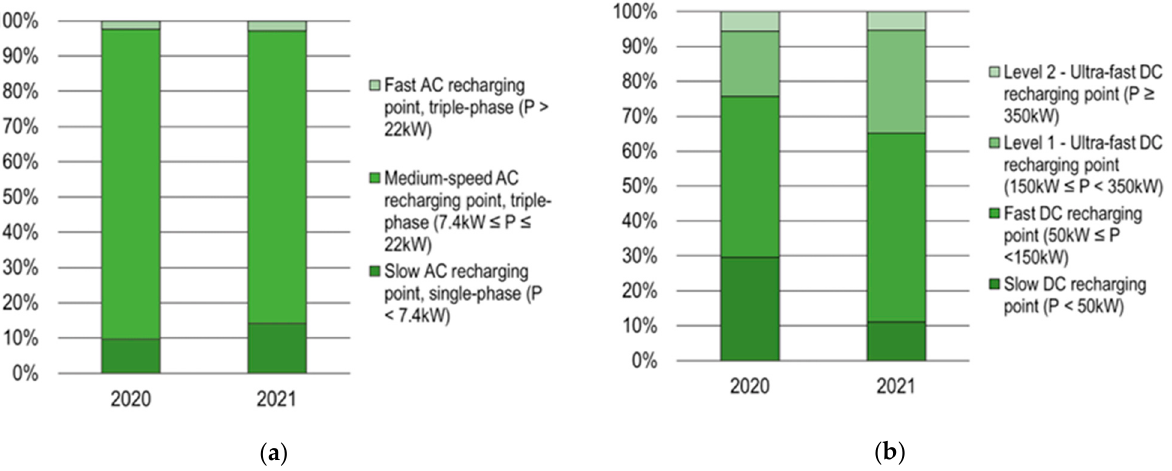
Figure 3. The share of fast and slow chargers at publicly accessible ( a ) AC charging points and ( b ) DC charging points.